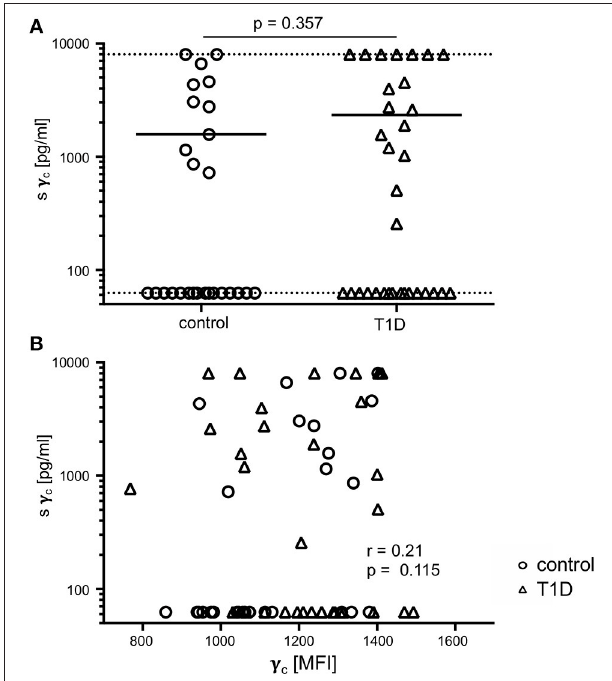
FIGURE 6 | Soluble (s) and membrane-associated γ c expression. (A) Serum concentrations of s γ c measured by ELISA are shown for healthy controls ( n = 27, open circles) and T1D patients ( n = 33, open triangles). The dotted lines indicate the upper and lower detection limit. Every symbol represents the mean of duplicates measured for an individual donor. Mean values of groups and the nominal p -value for the Mann-Whitney U-test (two-tailed) are indicated. (B) Correlation of serum concentrations of s γ c with membrane-associated γ c on CD4 + T-cells are shown (open circles: healthy controls, open triangles: patients with T1D). Spearman rank correlation coefficient ( r ) and p -value are indicated.